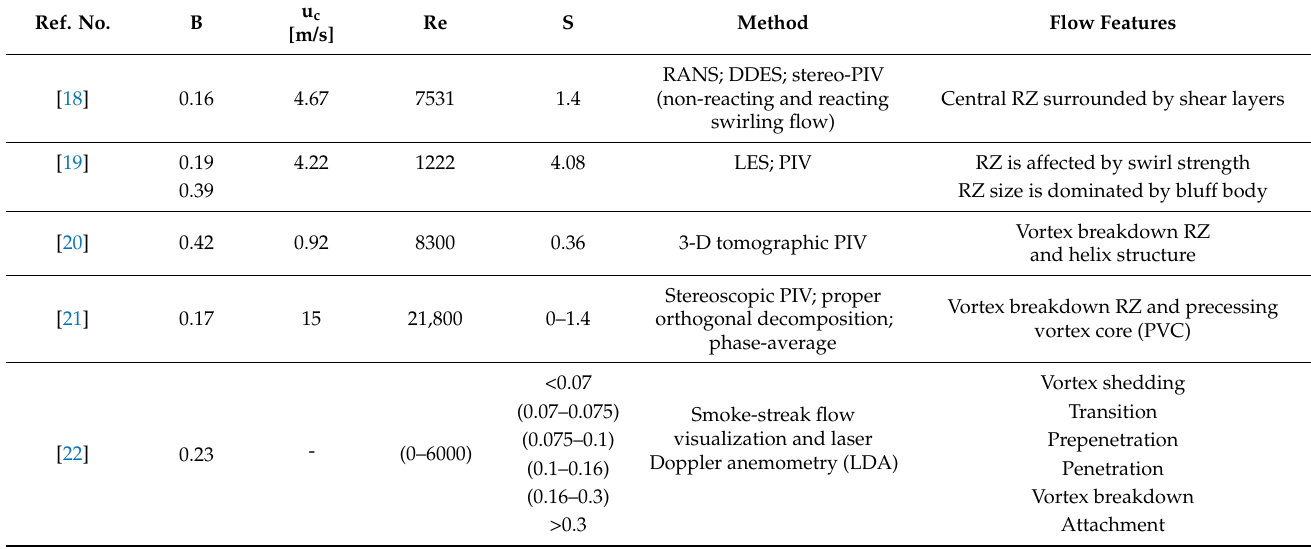
Table 1. Overview of literature publications on annular swirling jet with a bluff body installed. Ref.